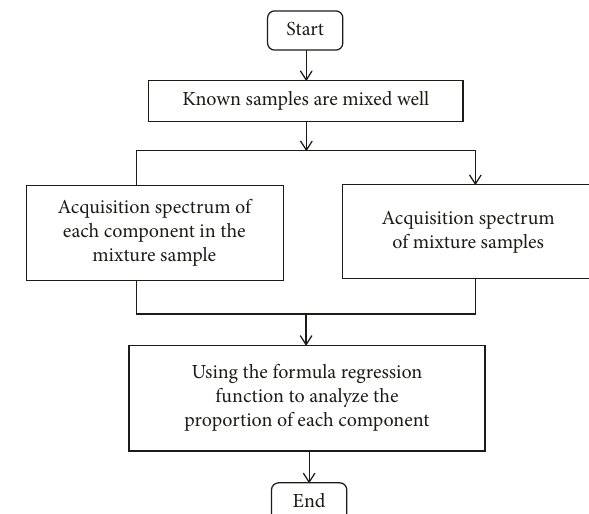
Figure 6: Flow chart for analyzing the percentage of each component in the